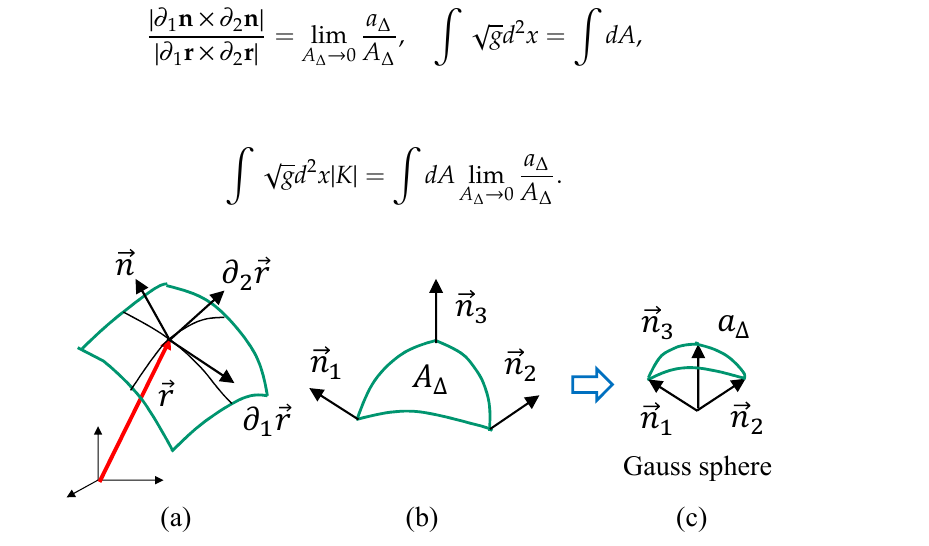
Figure 9. ( a ) Tangential vectors ∂ 1 r and ∂ 2 r , and the corresponding unit normal vector n on a smooth surface in (cid:60) 3 , ( b ) a smooth triangle of area A ∆ and with the normal vectors n i ( i = 1,2,3 ) at the vertices, ( c ) a part of the Gauss sphere of area a ∆ corresponding to the triangle in ( b